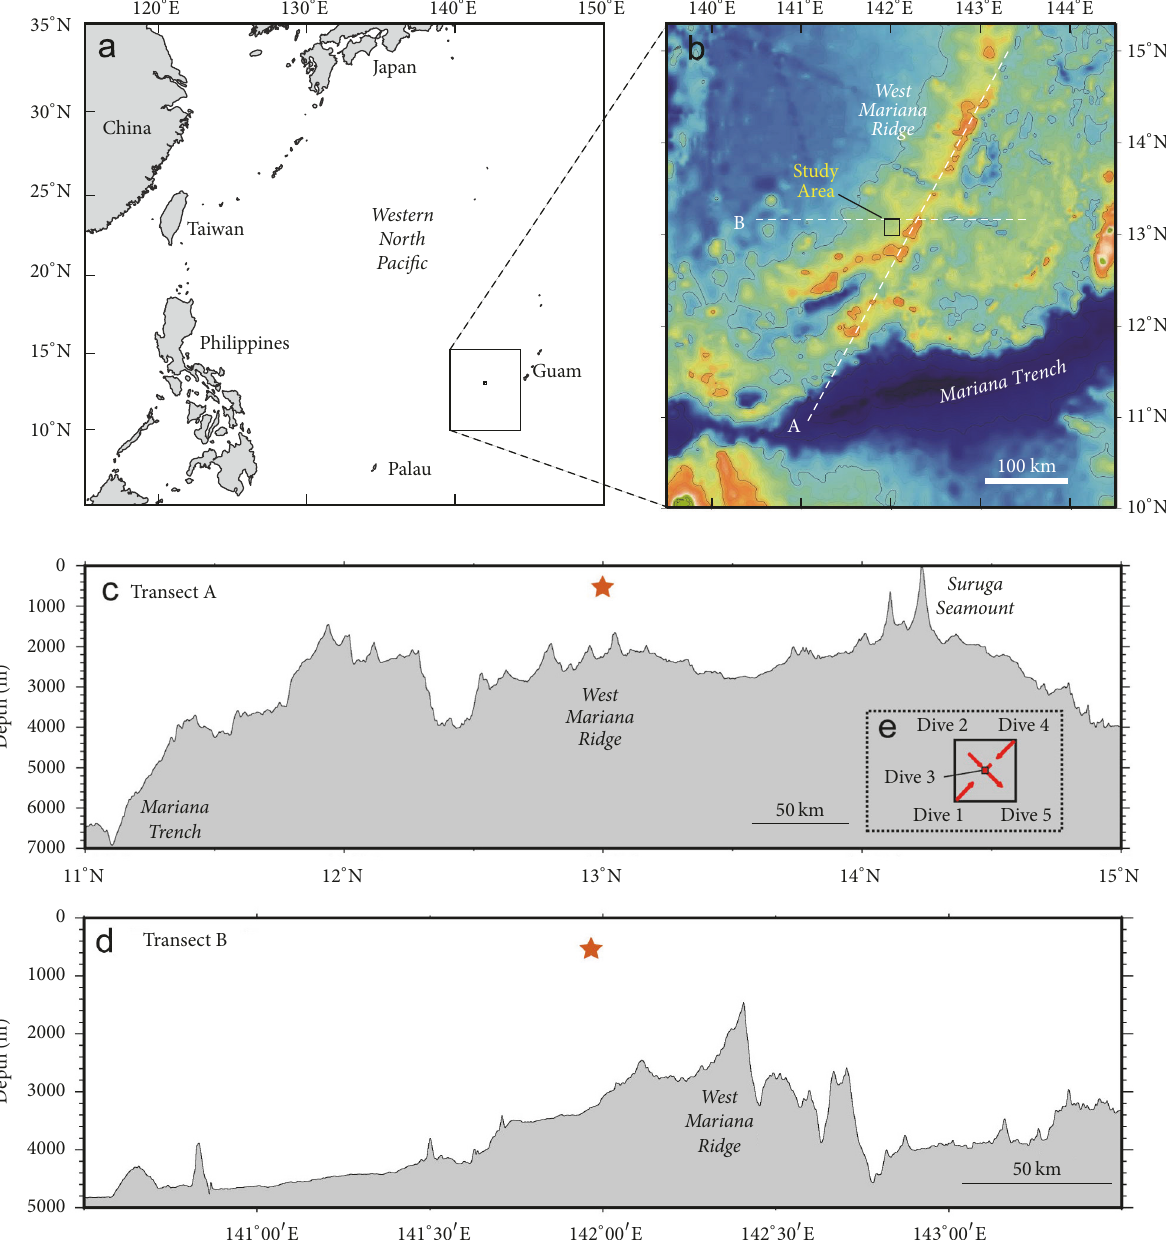
Figure 1: Location of the YK17-10 study area in the western North Pacific (a), the bottom topography of the southern West Mariana Ridge and Mariana Trench region showing the study area where underwater observations by the Shinkai 6500 submersible were made (small squares in (a, b)) along the west side of the ridge (b), and vertical profiles of bottom depth along transects (dashed lines in (b)) extending from the trench northward along the ridge (c; Transect A) and crossing the ridge longitudinally along the northern edge of the study area that includes the shallowest seamount in that part of the ridge (d; Transect B), with the location where the gelatinous giant octopod, Haliphron atlanticus , was seen, shown with stars. A diagram of the approximate horizontal directions and locations of the dive tracks of the submersible inside the study area square is shown in the inset (d). Color in (b) indicates deeper (blue/dark) and shallower (yellow-orange/lighter) depths.